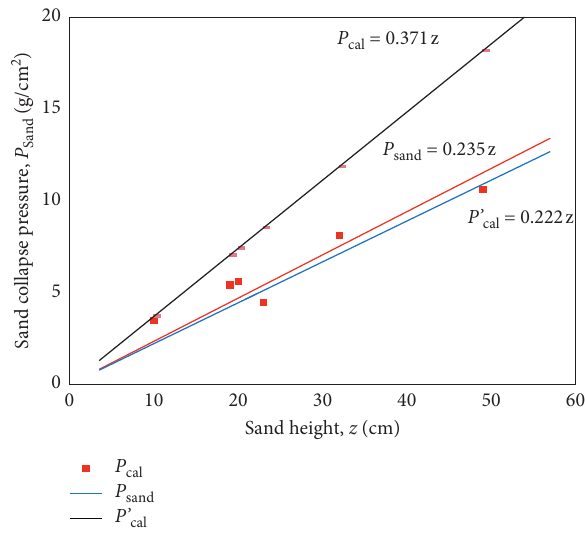
Figure 3: Comparison of the sand collapse pressure obtained by the preliminary sand experiment and calculated by Shulyak’s model and the model suggested in this study. P sand : measured pressure from preliminary sand experiment; P cal : calculated from Shulyak’s model; P’ cal : calculated from suggested ) and to verify height ( z ) and the sand collapse pressure ( P sand the statistical significance of the derived equations. The null hypothesis is that the regression coefficient for the sand height corresponding to the slope of the equation was zero. The results of simple regression analysis are presented in Table 5.